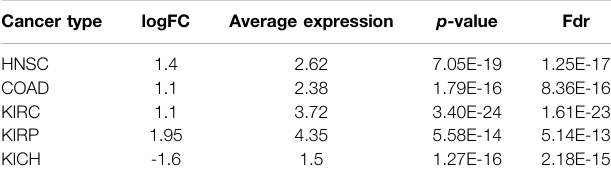
TABLE 4 | KDELC1 over-expression in TCGA